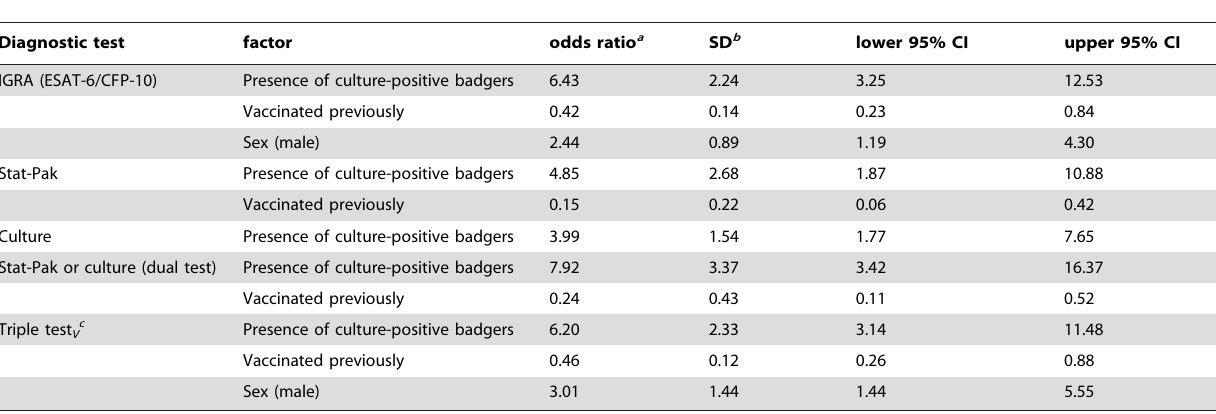
Table 1. Effects of BCG vaccination on the risk of individual badgers testing positive to a suite of diagnostic tests for M. bovis .